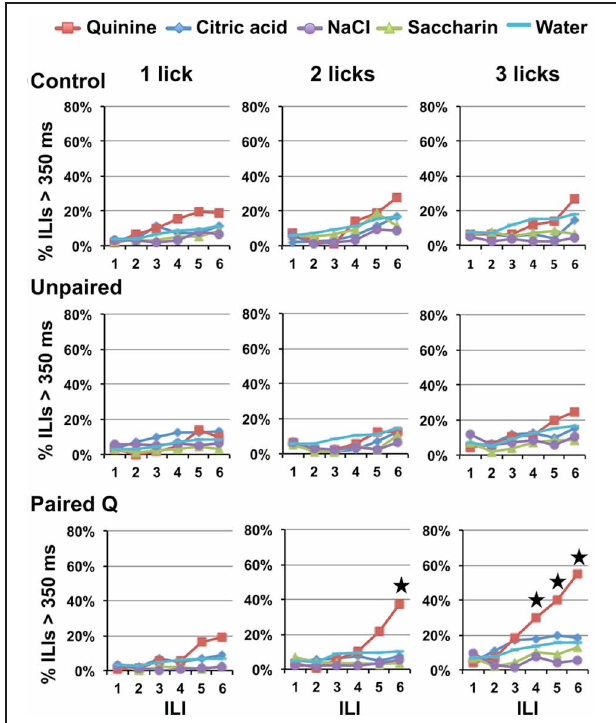
FIGURE 3 | Experiment 1A: effects of learning and reinforced stimulus presentations on avoidance. Percentage of ILI’s above 350ms for Control, Unpaired, and Paired Q groups at each of six ILIs following the first stimulus lick. One, two, and three-lick conditions are shown. Stars indicate significant difference at p < 0 . 05. Avoidance only occurs in rats that have learned to avoid quinine. Additionally, more reinforced stimulus presentations produces faster